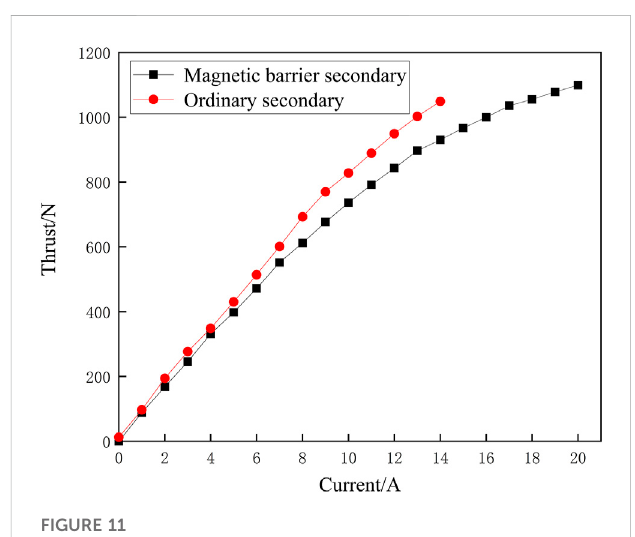
FIGURE 11 In fl uence of armature current on